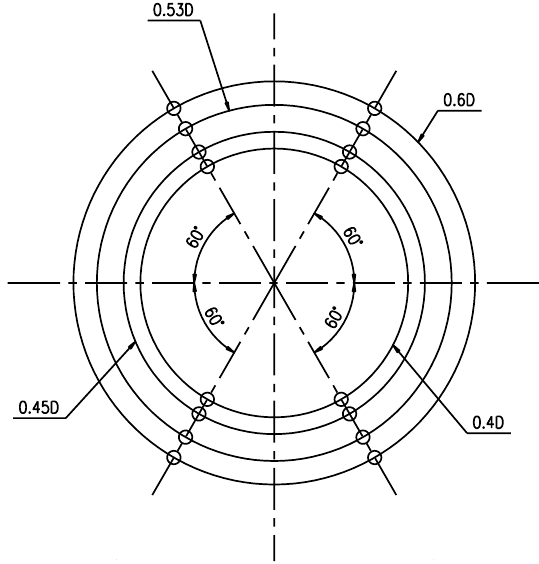
Figure 3. Layout of the bottom blowing element of the converter.